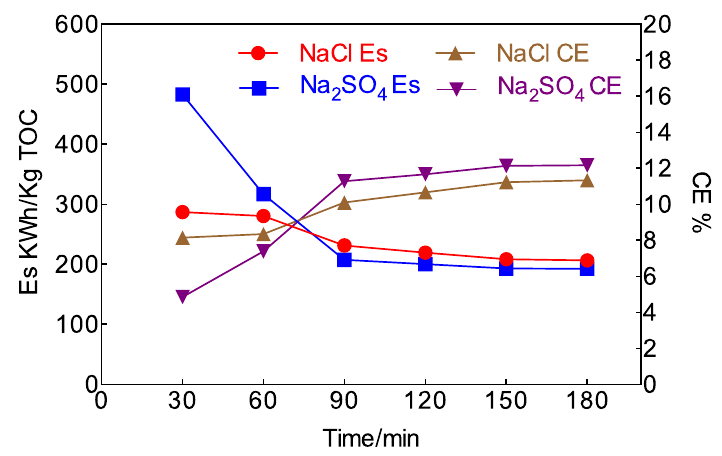
Figure 7. Es and CE of the recycling-flow 3D electro-reactor system with NaCl and Na 2 SO 4 as electrolytes (NaCl and Na 2 SO 4 initial concentration is 2 g / L; RhB wastewater initial concentration is 100 mg / L; volume is 500 mL; initial pH is 7; voltage is 7 V; HRT is 20 min; current density is 60 mA / cm 2 ).